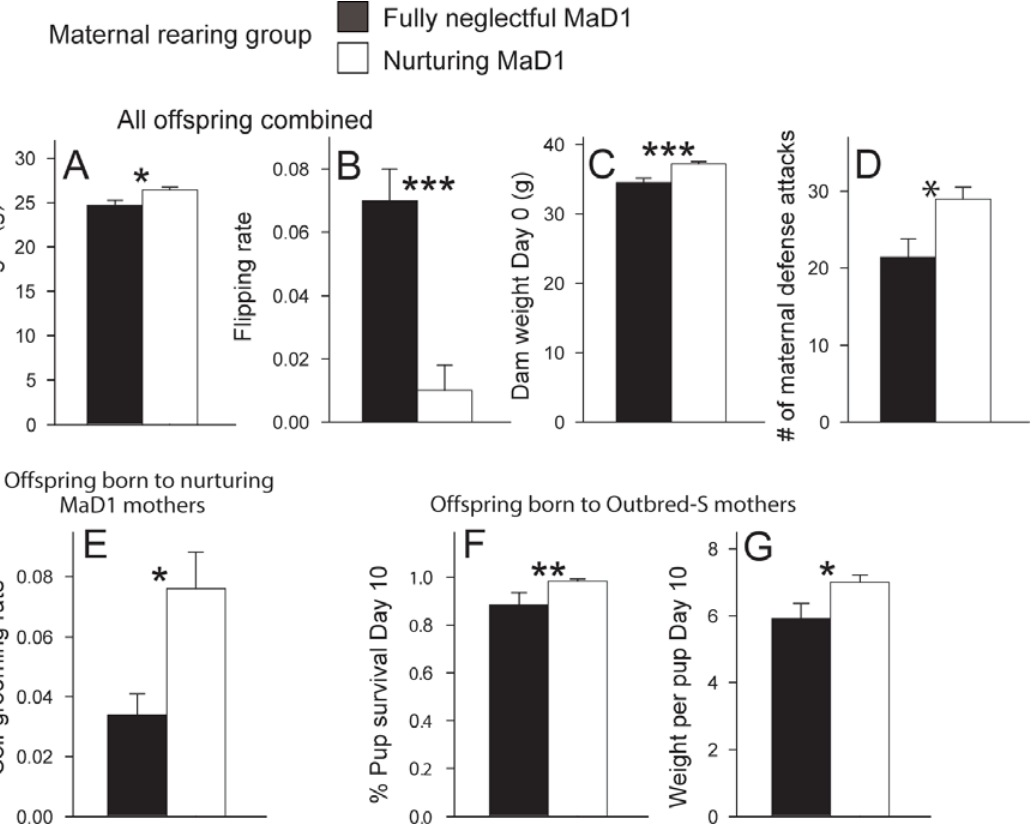
Figure 4. Cross-fostered offspring raised by previously neglectful (relative to nurturing) MaD1 mothers show deficits as adults. When results from all offspring were combined, previously neglectful MaD1 mothers negatively impacted offspring adult performance in terms of body weight pre-mating (A), flipping rate pre-mating (B), body weight on postpartum Day 0 (C), and number of maternal defense attacks (D). Additionally, when just offspring from previously nurturing MaD1 mothers were examined, they exhibited significantly lower levels self-grooming pre-mating when raised by a neglectful mother (E). When just offspring from Outbred-S mothers were examined as adults, deficits in terms of proportion of pups that survive to postpartum Day 10 (a marker of maternal neglect) (F), and the average weight of pups on postpartum Day 10 (G) were observed when these mice were raised by neglectful MaD1 mothers. Bars represent means 6 SE. * =p , 0.05; ** =p , 0.01.